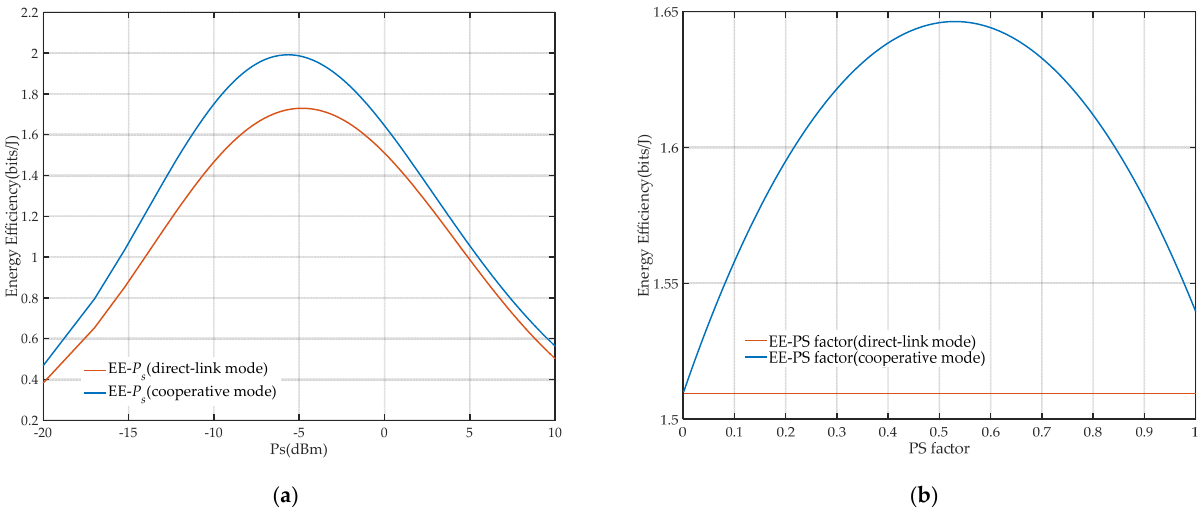
Figure 7. Influence curves of different parameters on EE: ( a ) BS transmission power 𝑃 (cid:3046) ( 𝑎 = 0.2 , 𝜌 = 0.6 ); ( b ) relay PS factor 𝜌 ( 𝑎 = 0.2 , 𝑃 (cid:3046) = 1 ).